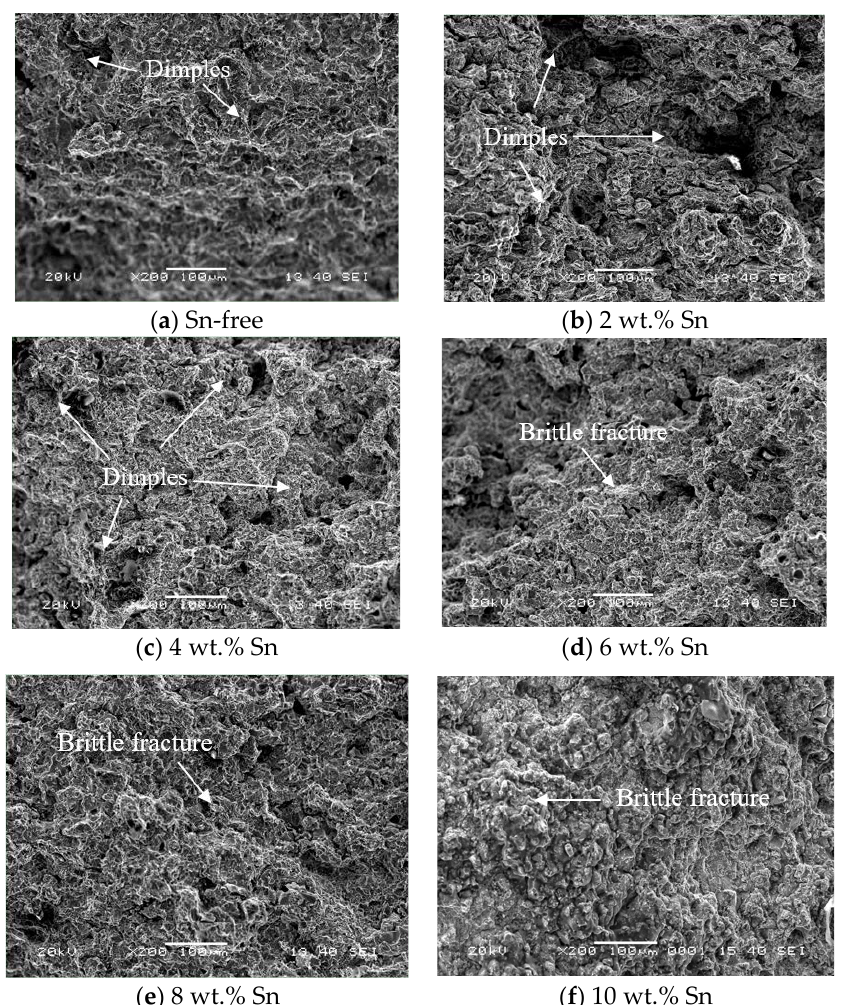
Figure 8. SEM fracture of matrix after three-point bending with different Sn contents.